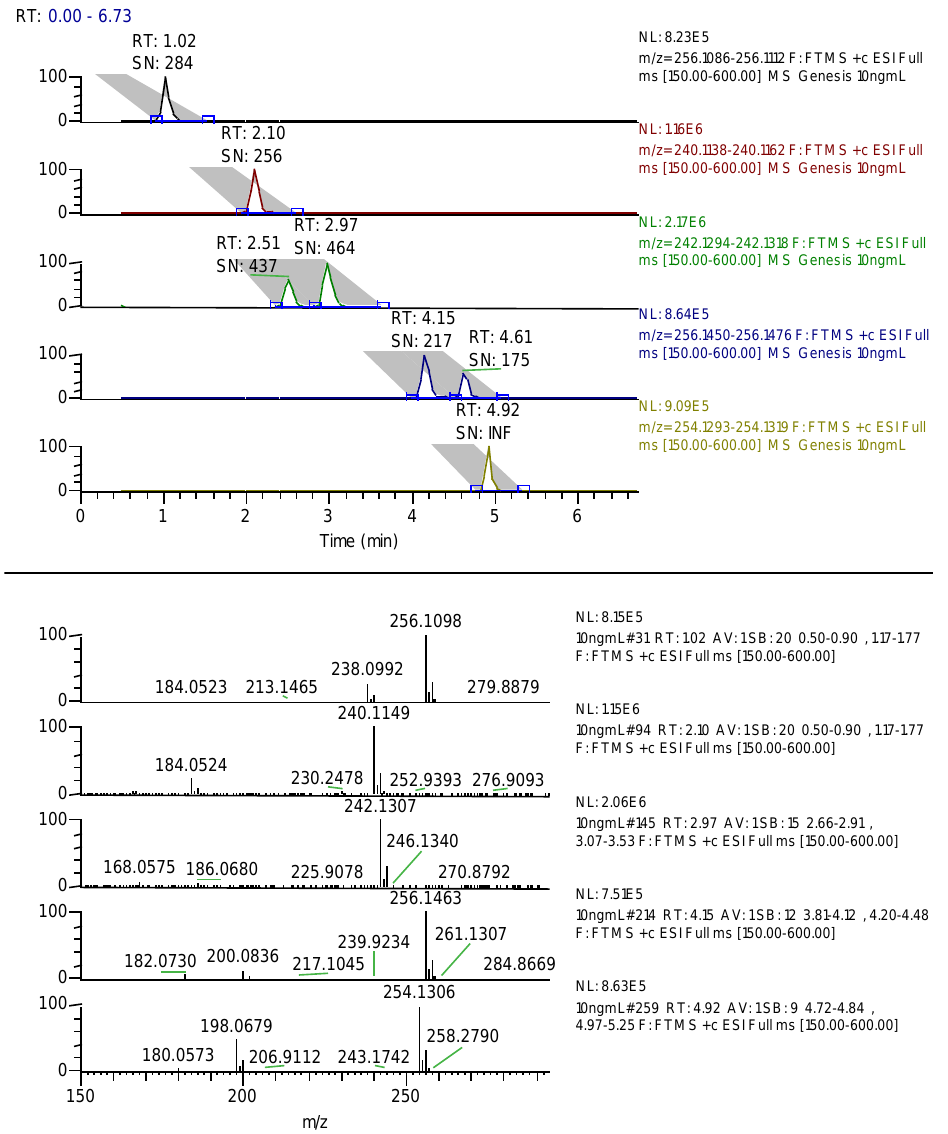
Figure 1. LC-FTMS chromatogram of hydroxybupropion 1.02 min, bupropion 2.1 min, erythro -hydrobupropion 2.51 min and threo -hydrobupropion 2.97 min, N -methyl- erythro -hydrobupropion 4.15 min, N -methyl- threo -hydrobupropion 4.61 min and the prodrug N-methylbupropion 4.92 min each at 10 ng/mL. Under the peak retention times is the signal to noise ratio SN. G:\LCMS